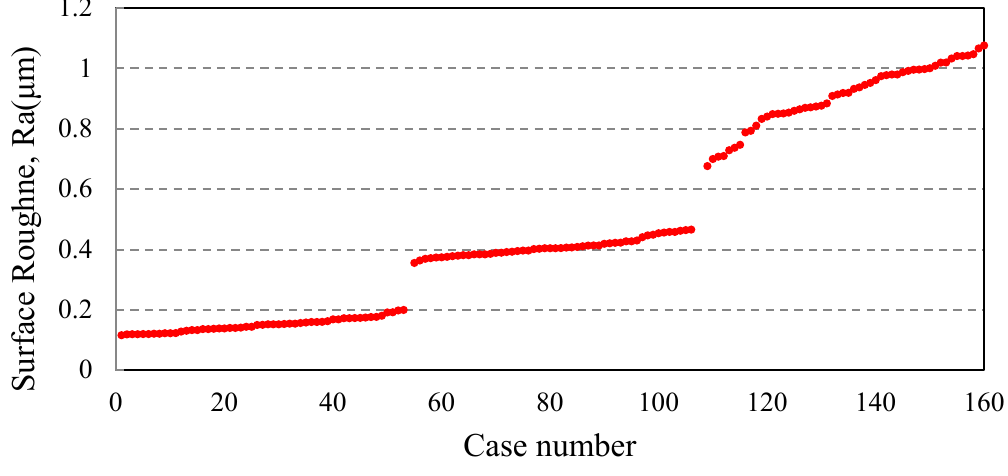
Figure 10. Surface roughness distribution.